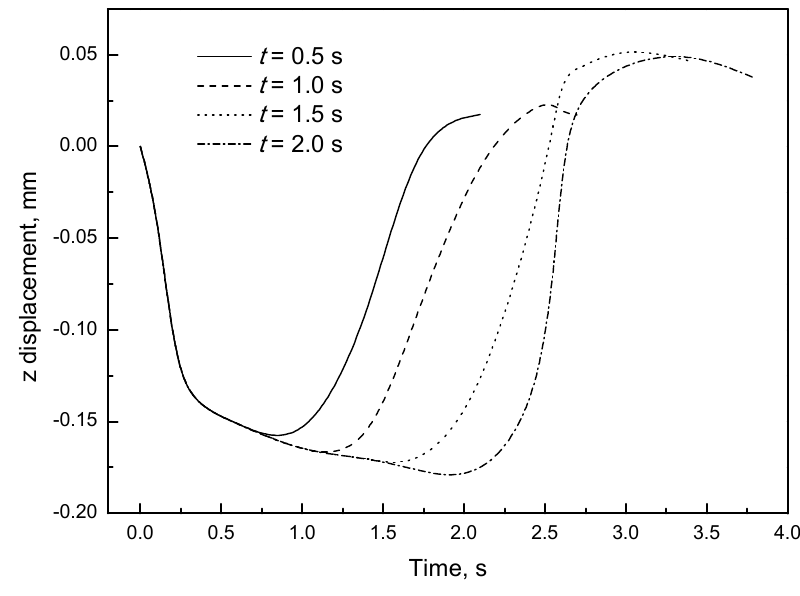
Figure 11. Variation of displacement with irradiation